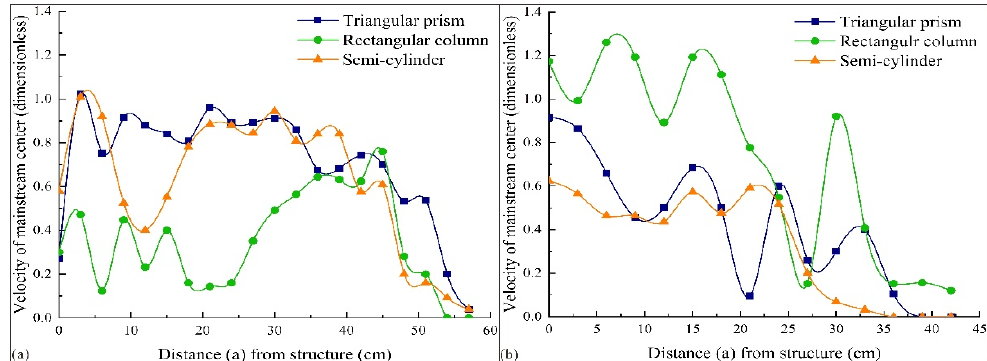
Figure 8. Variation in the velocity along the deflection mainstream center: ( a ) l = 0.31; ( b ) l = 0.56 (a is the straight-line distance from each point of the deflected mainstream to the structure).